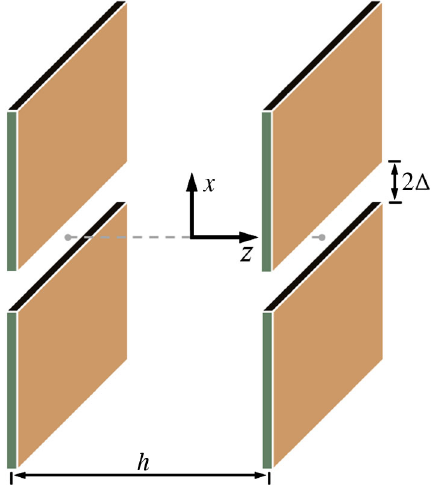
FIG. 1. Geometry of the problem. Slits, defined by z ¼ (cid:5) h= 2 , j x j < (cid:2) , have been cut in the infinitesimally thin walls of a parallel-plate waveguide. Empty space fills the regions j z j (cid:9) h= 2 and between the slotted screens. E y (cid:8) 0 at the